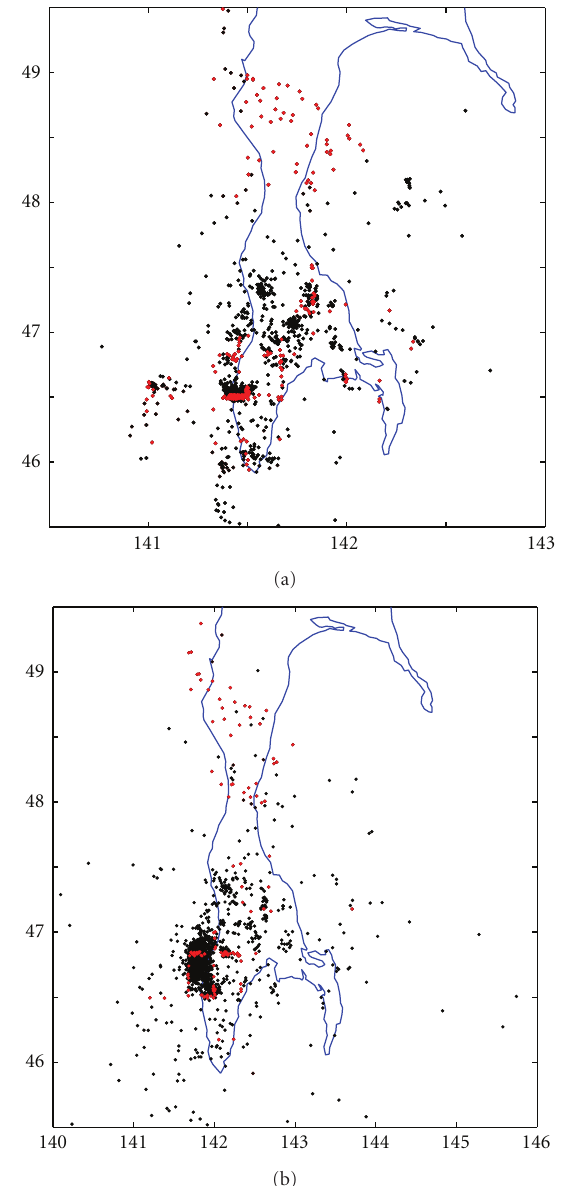
Figure 9: Location of earthquakes with typical ( p < 0 . 55, black points) and with increased values of parameter of metastability ( p > 0 . 55, red points). (a) events occurred before the Nevelsk earthquake; (b) events occurred after the Nevelsk